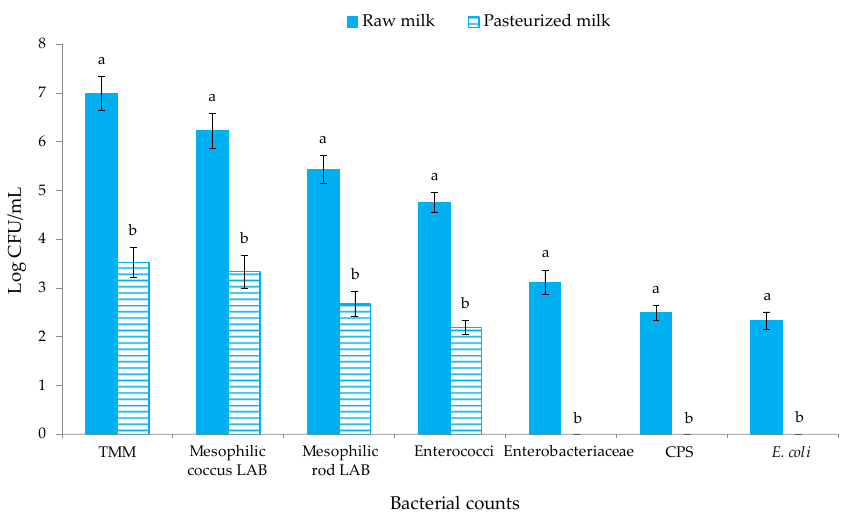
Figure 2. Microbial counts (Log CFU/mL) of raw and pasteurized milk samples. Abbreviations: TMM, total mesophilic microorganisms; CPS, coagulase-positive staphylococci; E. , Escherichia . The results indicate the mean values and standard deviation of four plate counts (carried out in duplicate for two independent productions). Different superscript letters indicate significant differences in the microbial concentrations according to Tukey’s test between the raw and pasteurized milk samples for p < 0.05.